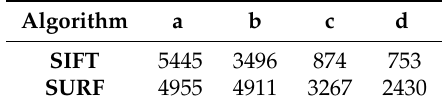
Figure 4. Sample images from the CE-3 PCAM (Panoramic Camera). ( a , b ) are adjacent images under sidelight; ( c , d ) are adjacent images under frontlighting. Table 2. The number of extracted feature points. Algorithm